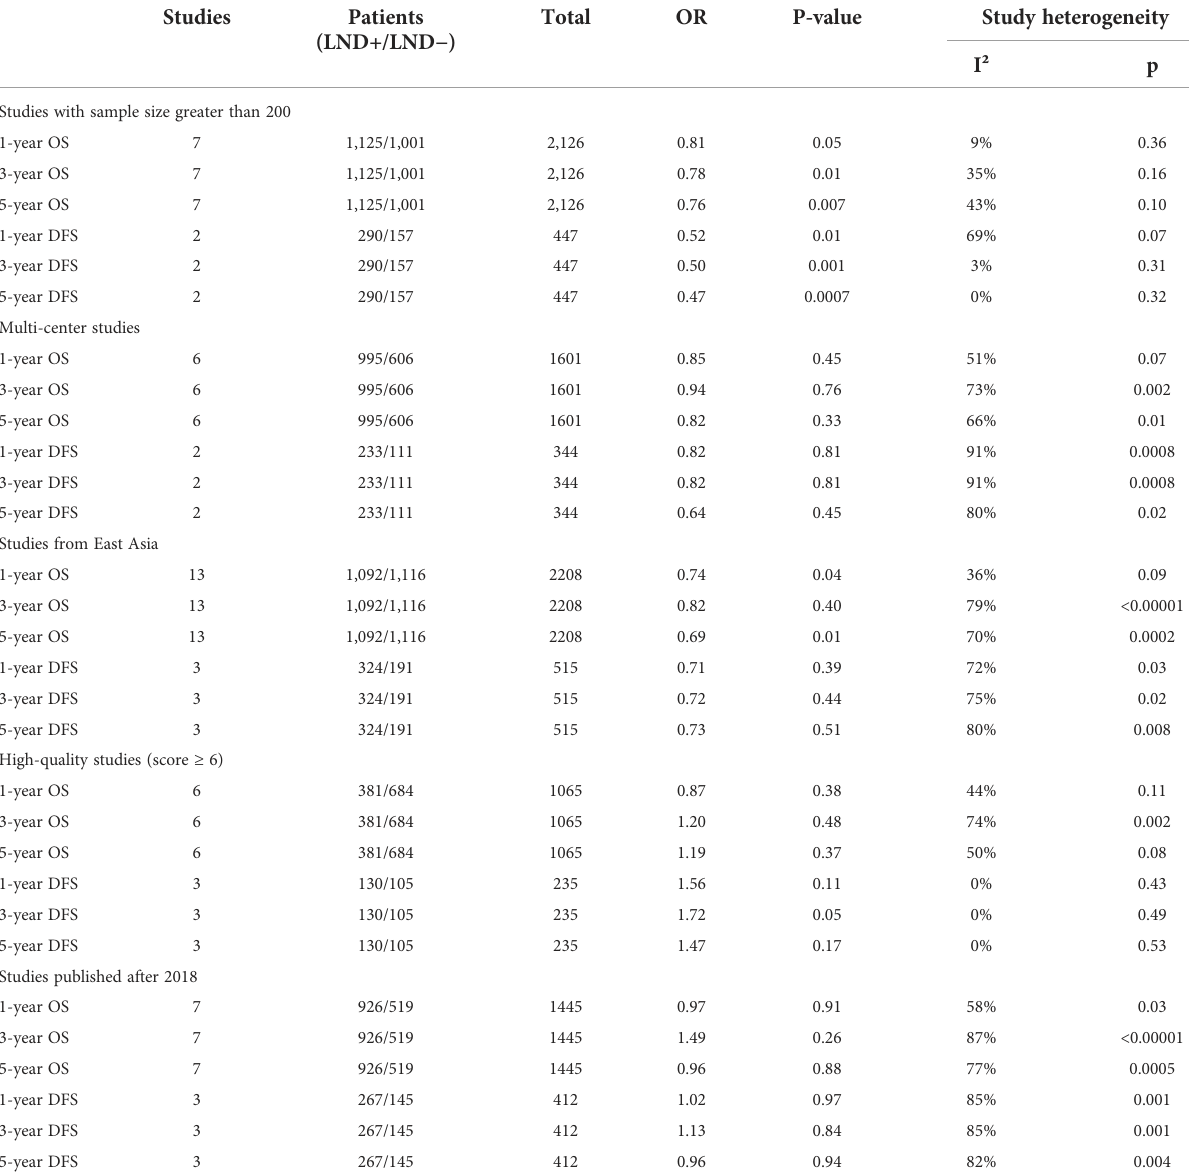
TABLE 1 Sensitivity analysis among